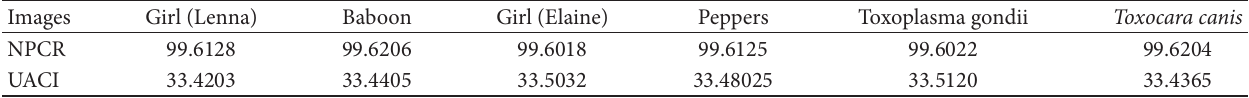
Table 5: NPCR and UACI of some ciphered